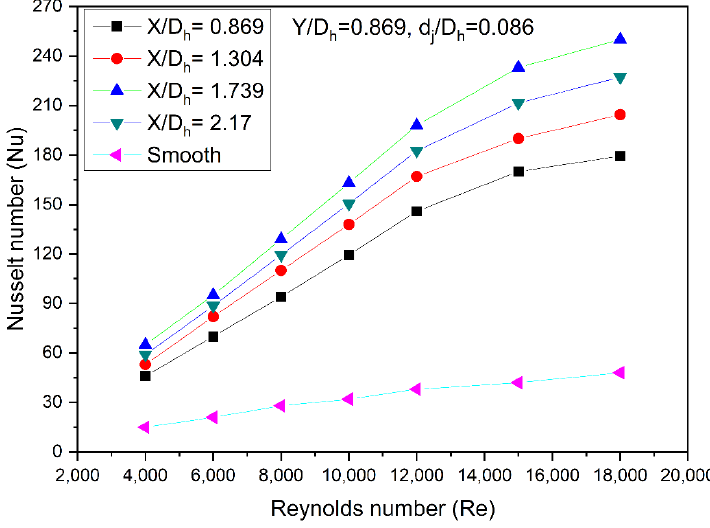
Figure 6. shows variation in (cid:10)(cid:11) with (cid:8)(cid:9) for different ranges of (cid:24)/(cid:22) . (cid:23) (cid:23) The air jet impinging on the spherical protrusion surface is seen in Figure 7. The air jet striking the spherical protrusion spreads over the protruded surface as well as the flat heated surface and disrupts the larger laminar sub-layer, thus eliminating larger hot zone areas, which leads to augmented heat transfer. Figure 8 reveals the effect of (cid:25)/(cid:22) on (cid:10)(cid:11) (cid:23) at various (cid:8)(cid:9) values for an (cid:24)/(cid:22) of 1.739 and a (cid:19) of 0.086. It is seen that the (cid:10)(cid:11) (cid:23) (cid:20) /(cid:22) (cid:23)